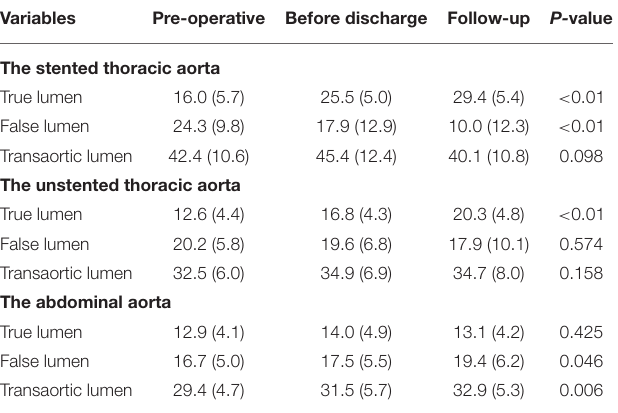
TABLE 2 | Maximum diameters of the true lumen (TL), false lumen (FL), and total lumen (transaortic) over time in the stented thoracic aorta, unstented thoracic aorta, and abdominal aorta.